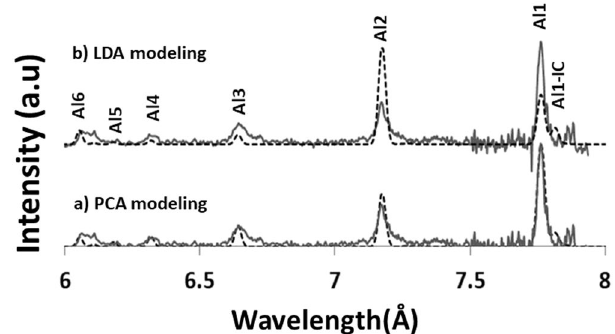
Figure 8. Experimental spectrum versus LDA and PCA model produced calculated spectrum ( T e = 100 eV, n e = 5 × 10 20 cm − 3 and f =